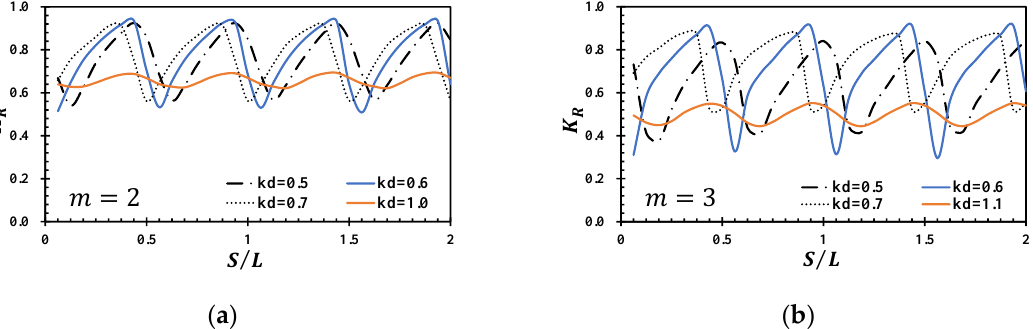
Figure 10. Variation of the reflection coefficient K R with S / L for the different wave periods kd . ( a ) 𝑚 = 2 . ( b ) 𝑚 = 3 .